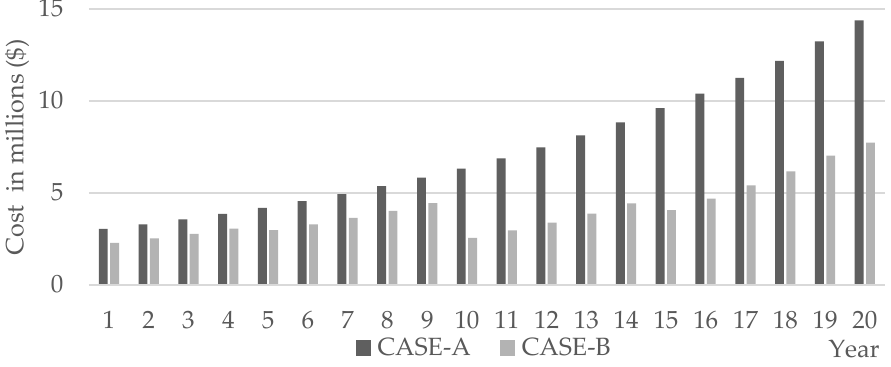
Figure 5. Comparison of the annual energy cost bought from the grid through the planning period.